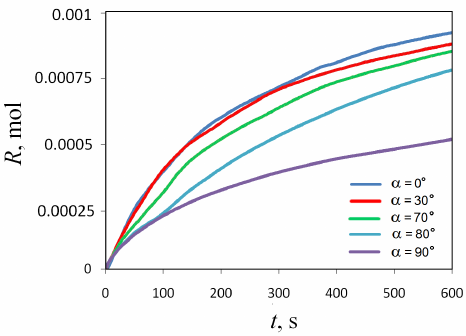
Figure 15. Temporal evolution of the amount of the reaction product R ( t ) measured at different inclination angles of the slot.